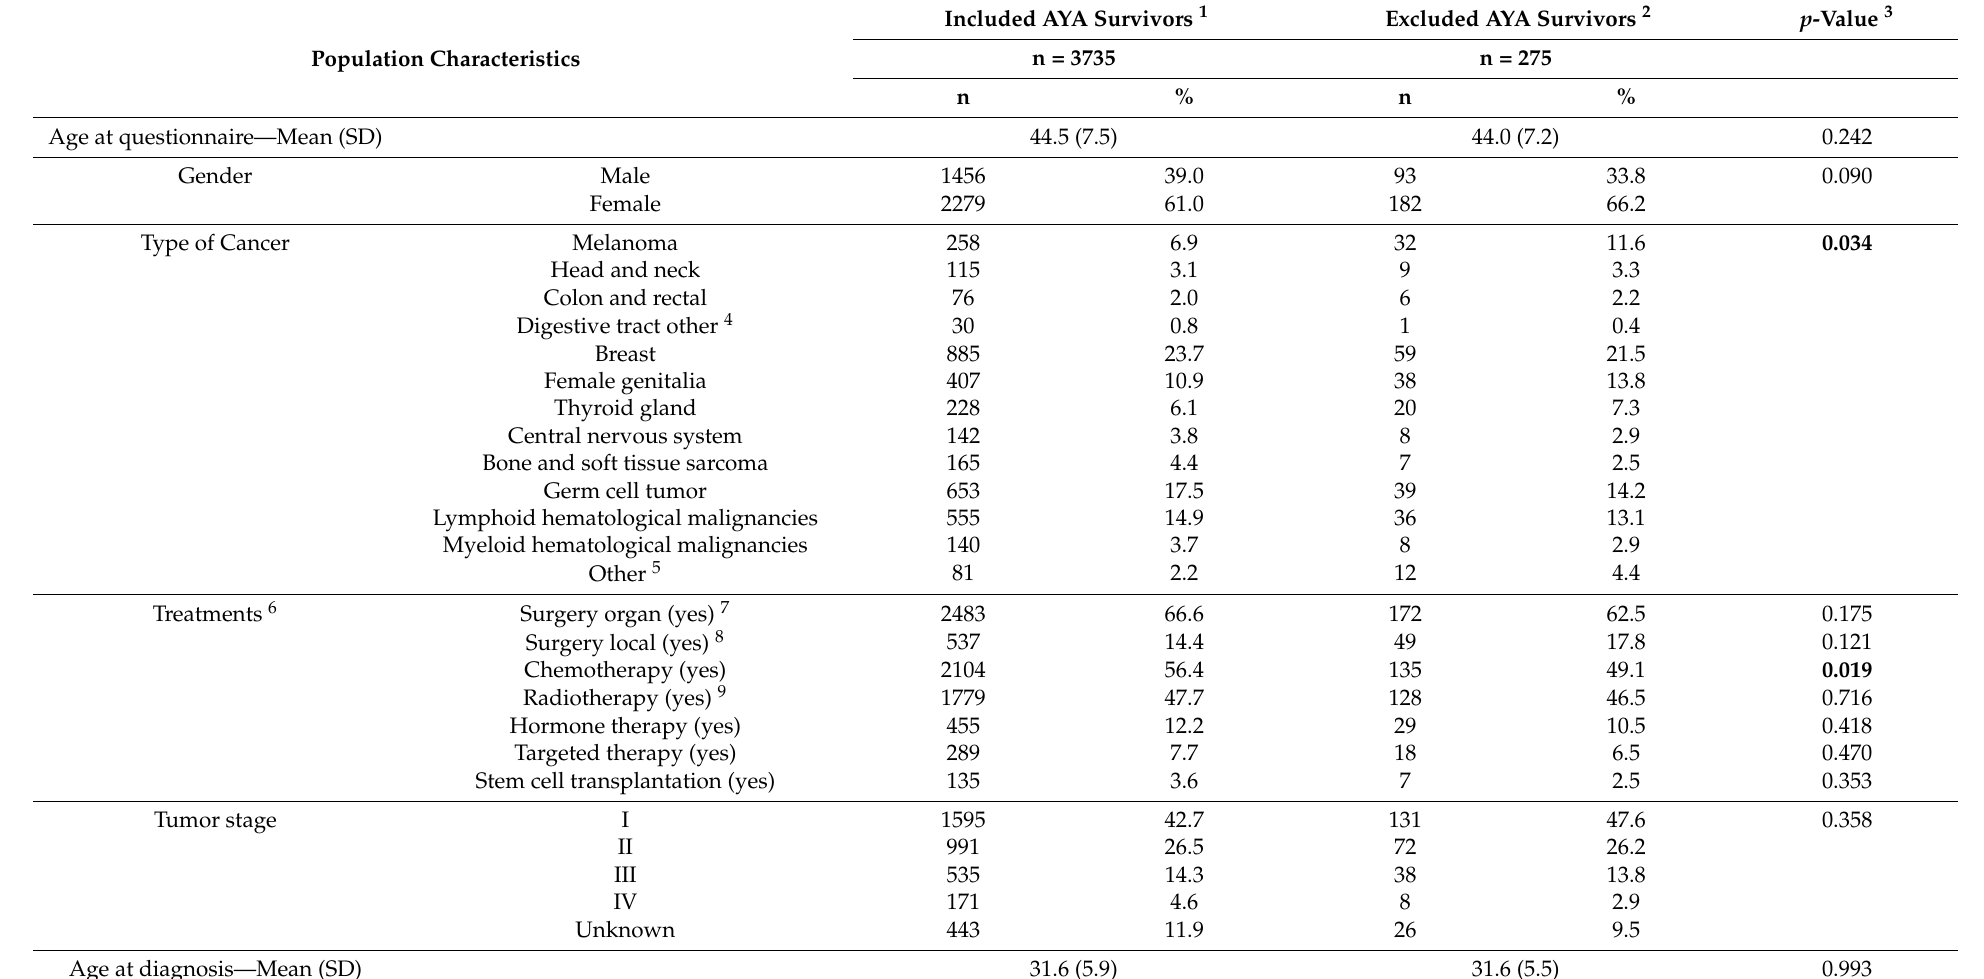
Table 1. Differences in characteristics of the included and excluded AYA